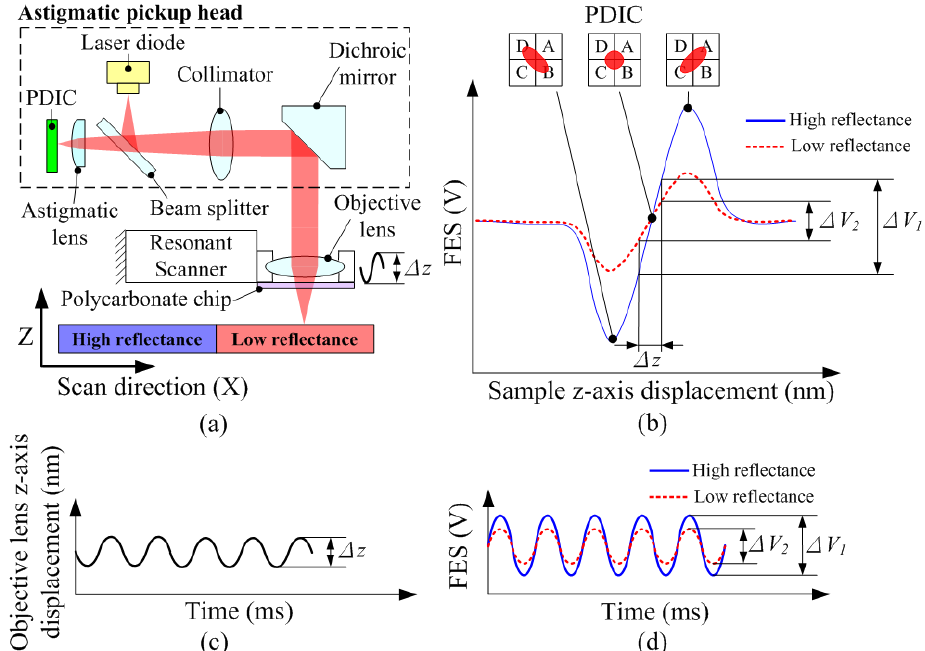
Figure 1. ( a ) Optical configuration for the reflectance measurement. ( b ) FES vs. sample z-axis displacement curves with different surface reflectances. ( c ) objective lens z-axis displacement vs. time curve. ( d ) FES vs. time curves with different surface reflectances.